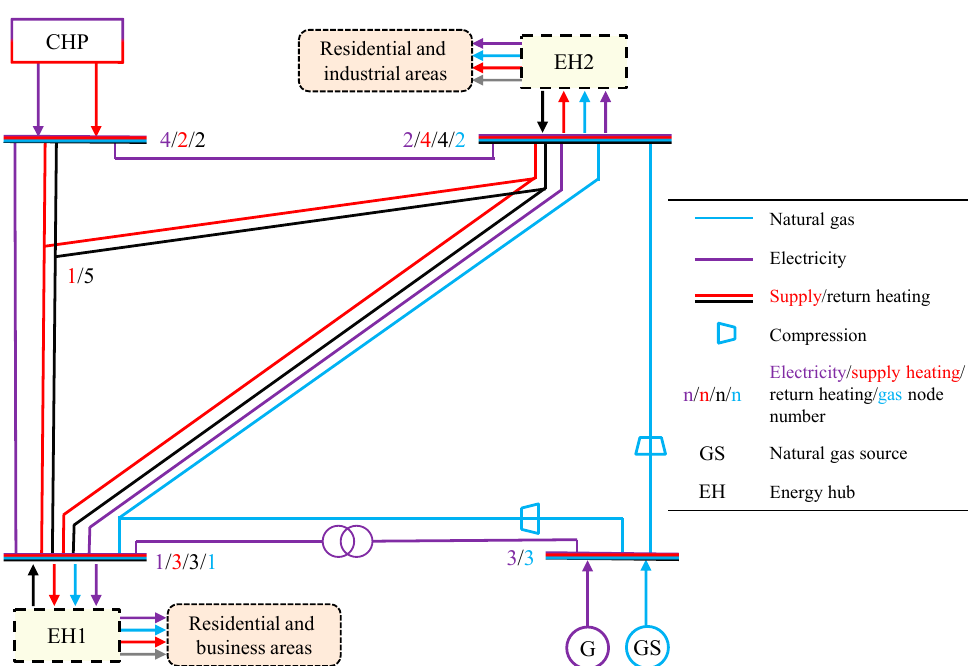
Figure 5. Structure diagram of the IES based on an EH. Table 1. Topology information of the IES case.